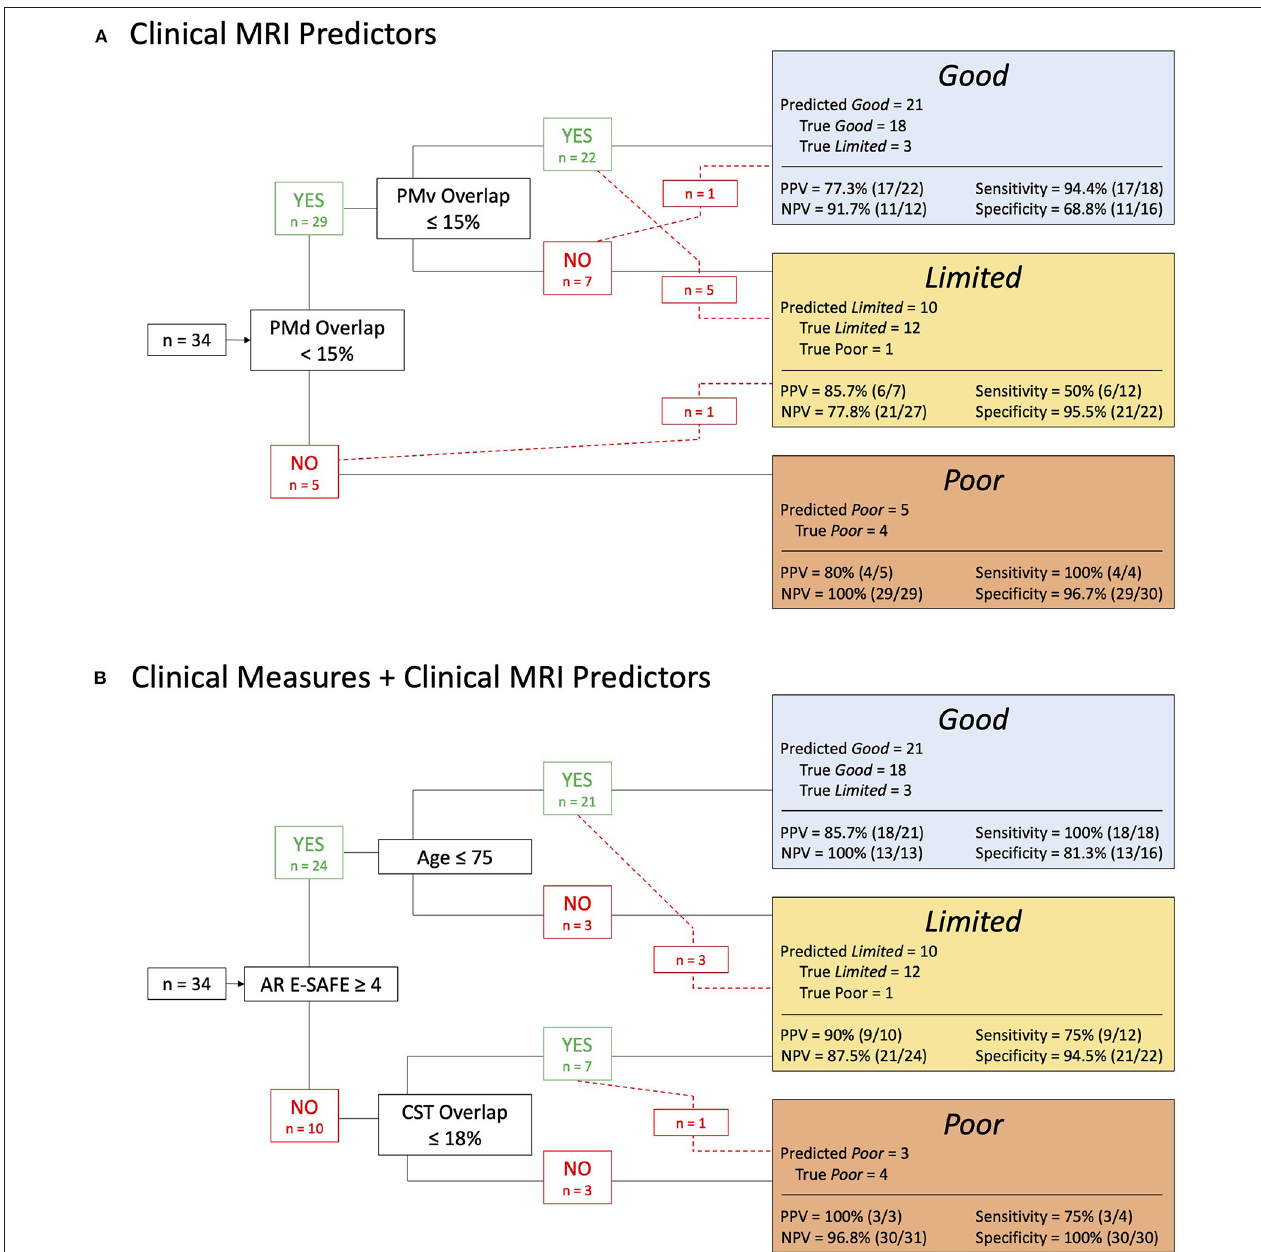
FIGURE 5 | (A) Dorsal (PMd) and ventral (PMv) premotor tract overlap predicts paretic upper extremity (PUE) outcome category with 79% accuracy. (B) Estimated shoulder abduction finger extension manual muscle test score assessed at admission to acute inpatient rehabilitation (AR E-SAFE), patient age, and corticospinal tract (CST) lesion overlap % predicts PUE outcome category with 88% accuracy. PPV, positive predictive value; NPV, negative predictive